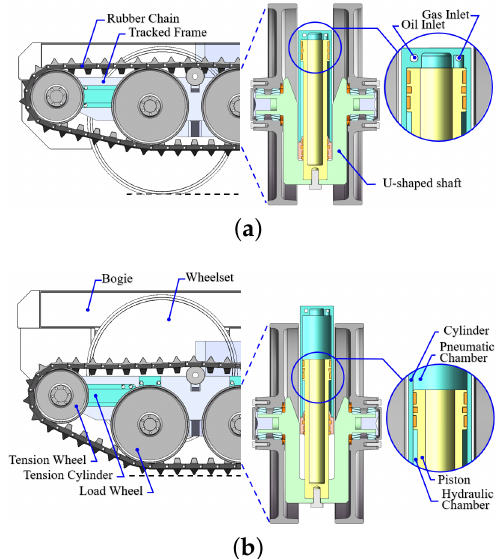
Figure 3. Tracked chassis suspension status in two operation modes ( a ) Rail operation mode ( b ) Road operation